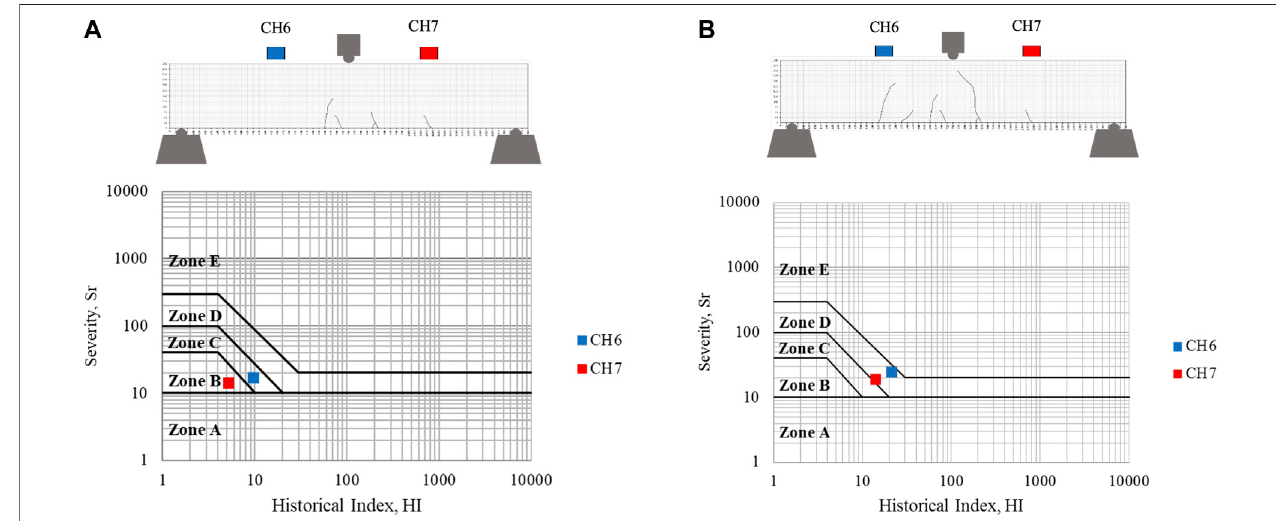
FIGURE 13 | The crack zones obtained from CH6 and CH7 for beam S2B under (A) CM3 and (B) CM4.